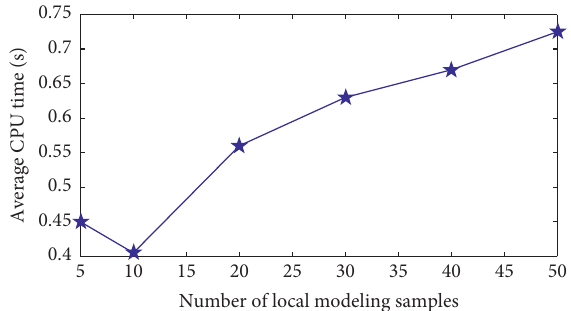
Figure 8: Average CPU time for online prediction using the proposed MP-EJITGPR (FMM)